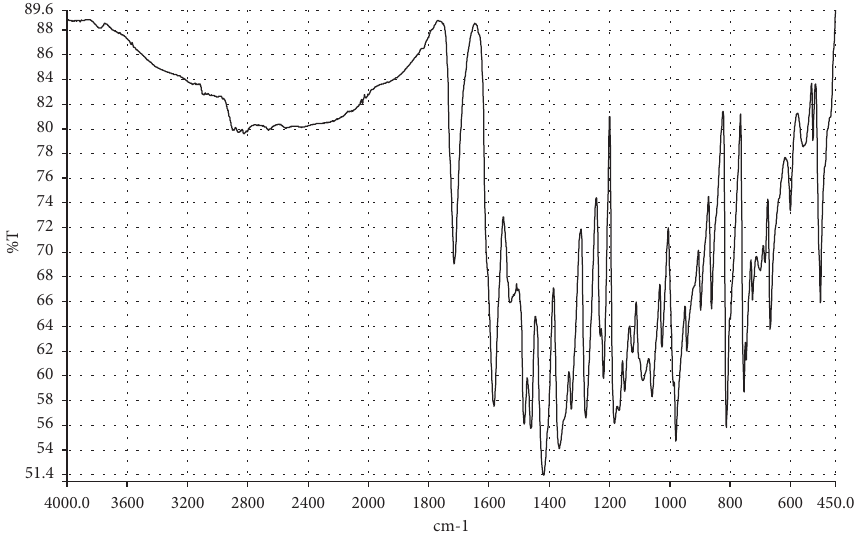
Figure 1: FTIR spectrum of coumarin 3